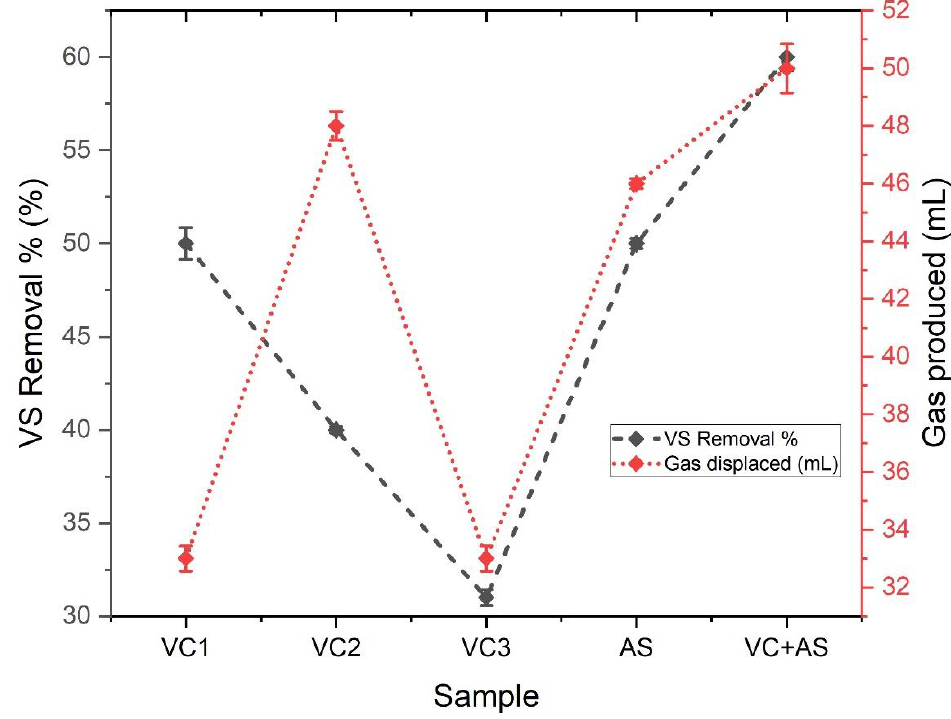
Figure 8. VS removal efficiency and gas produced in different reactors.